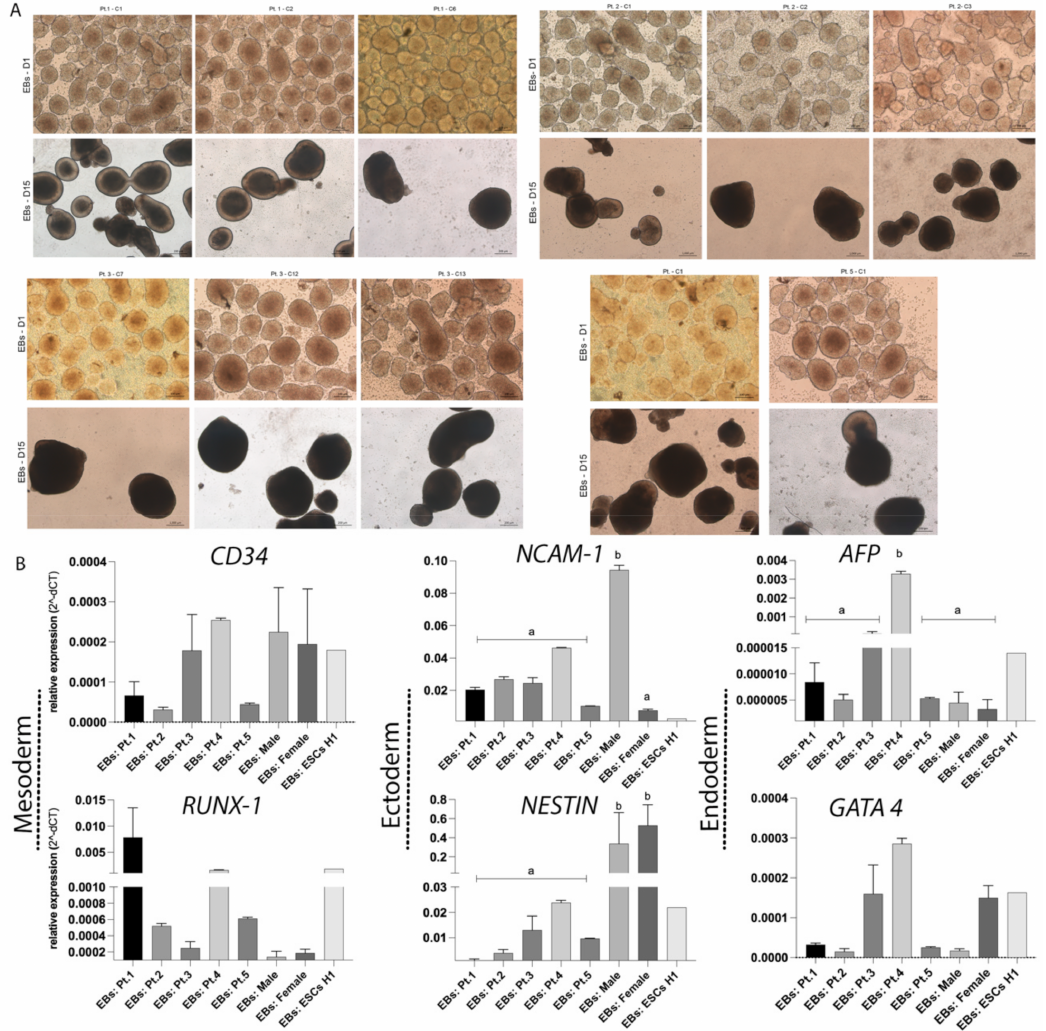
Figure 3. The in vitro differentiation capacity of hiPSCs-TS and subclones into EBs. ( A ) Embryoid body formation after 24 h and 15 days of differentiation. Scale bar: 200 µ m. ( B ) Quantification of the relative expression of NESTIN , NCAM1 , RUNX1 , CD34, AFP and GATA-4 genes in all EBs lines and subclones (D.15). Individual reactions of qRT-PCR were normalized to the B-ACTIN gene. The ESCs-H1 line was used as a positive control and was not considered in the statistical model. All qRT-PCR from EBs-TS and control data were compiled from at least three biological and technical replicates. p values were calculated by Two-way ANOVA, followed by Tukey’s multiple comparisons test as appropriate (letters a–b show difference between groups). Erros bars denote represent